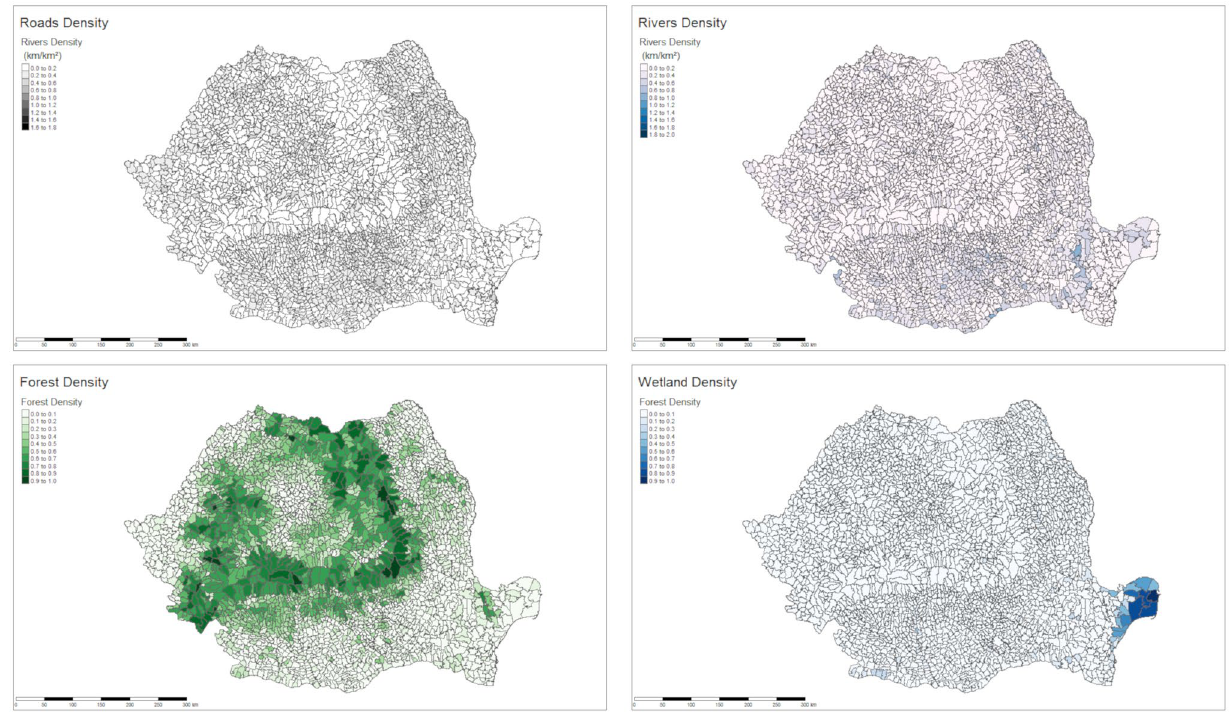
Figure 1. Cartography of the geographic variables. All data are presented as densities at the commune